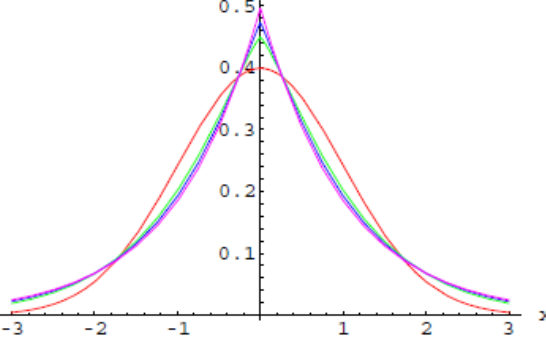
Figure 3. The univariate  -order generalized Normals